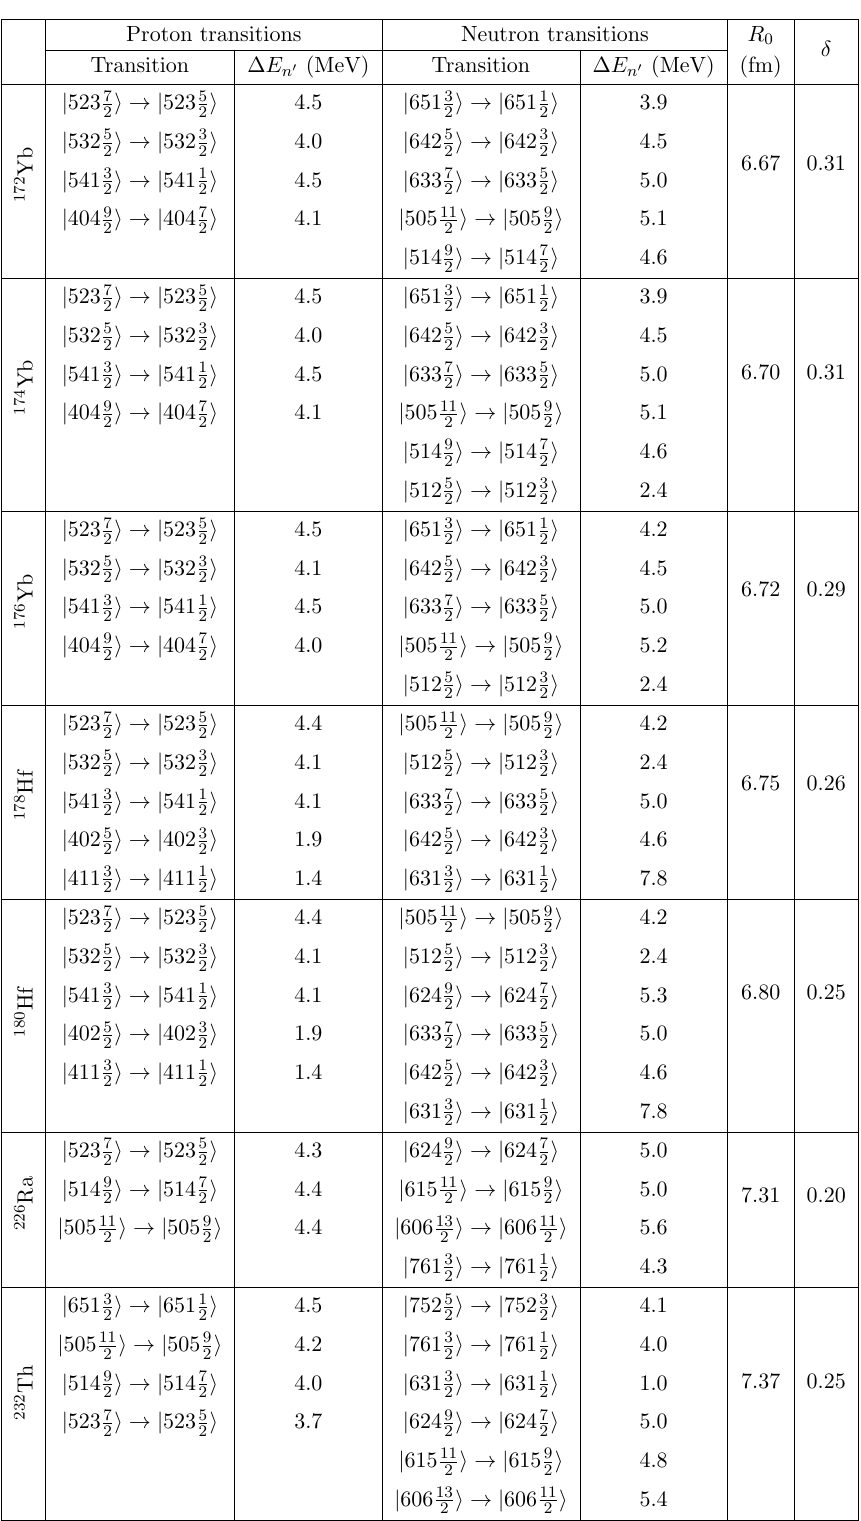
Table 4 . Nuclear radii R 0 , deformation parameters (cid:14) and energies (cid:1) E n 0 of M1 spin-(cid:13)ip transitions in some deformed nuclei of